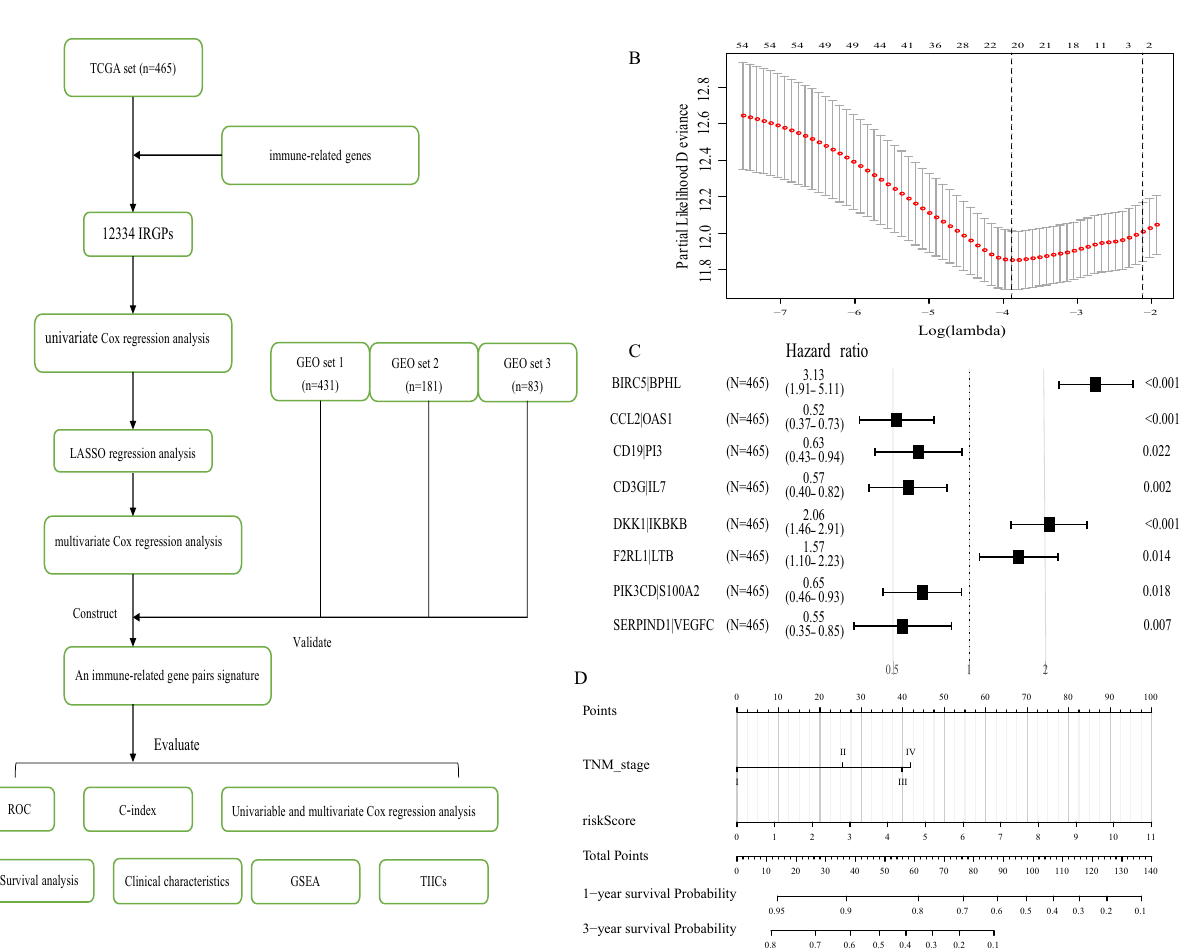
Figure 1. Construction of a IRGPs signature in the TCGA set. ( A ) The flow diagram of this study. ( B ) “Leave- one-out-cross-validation” for parameter selection in LASSO regression to filter out 21 IRGPs. ( C ) The forest map of multivariate Cox regression analysis to establish a IRGPs signature with 8 IRGPs. ( D ) A nomogram with the IRGPs signature and TNM stage for the prediction of 1- and 3- year overall survival. TCGA: The Cancer Genome Altas; IRGPs: Immune-related gene